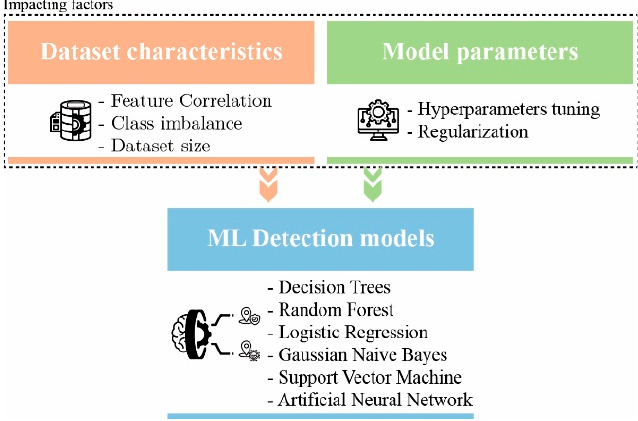
Figure 1. Overview of dataset characteristics and model parameters for detecting GPS spoofing attacks targeting UAVs.